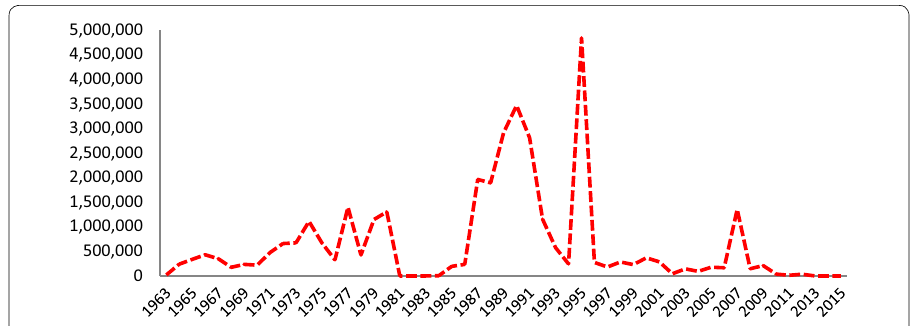
Fig. 2 Workdays lost to strikes (annual, 1963–2015) Source : Data were derived from Ministry of Labor and Social Security,